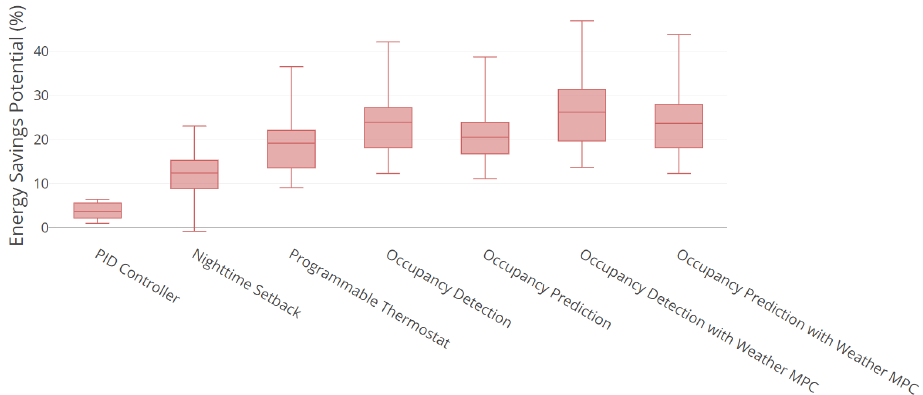
Figure 2. Boxplot of potential savings by control strategy for ten households [%]; adapted from Reference